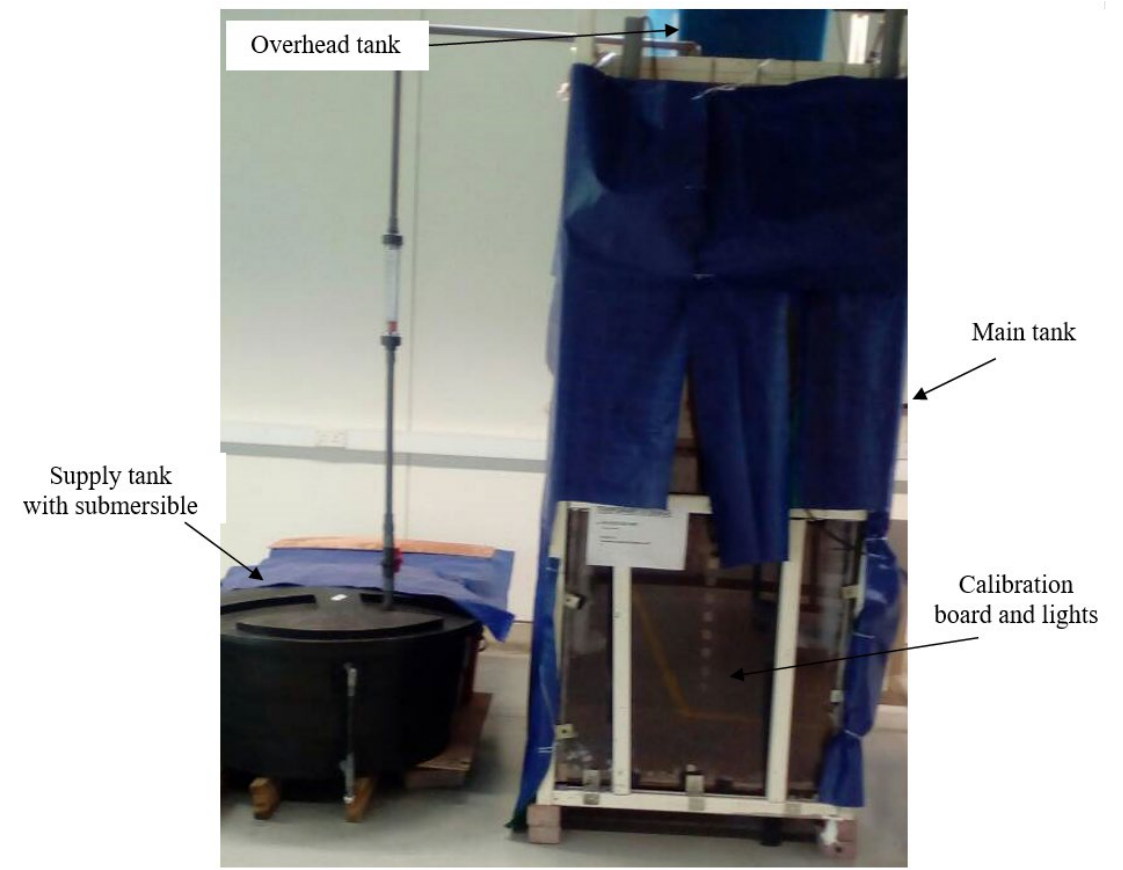
Figure 1. Experimental setup used for plume simulation including schematic ( above ) and actual setup ( below ).